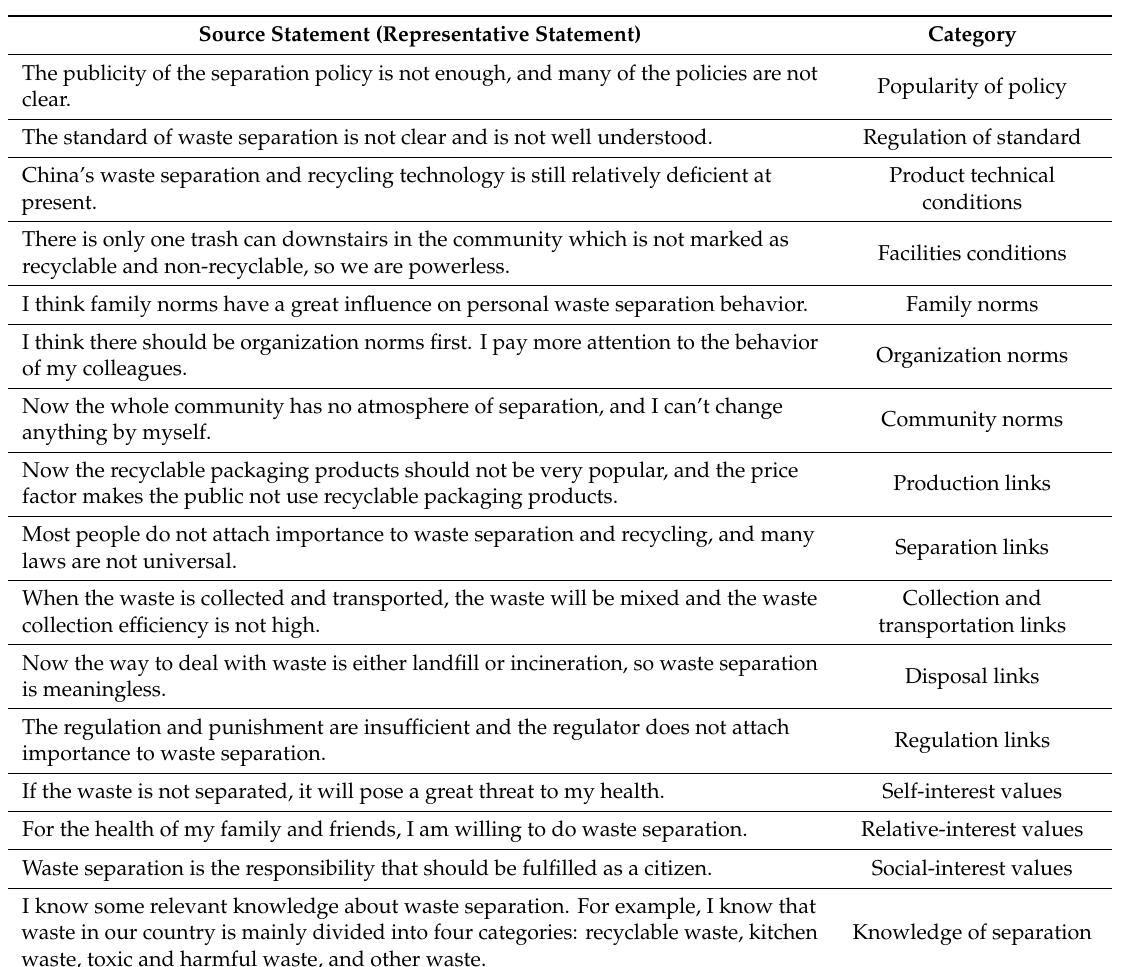
Table 4. Process and results of open coding for the driving factors of waste separation